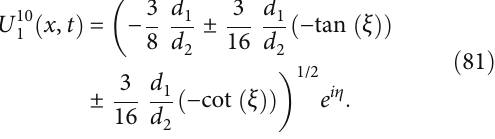
ð x , t Þj for NLFD of order α and for parameters δ 2